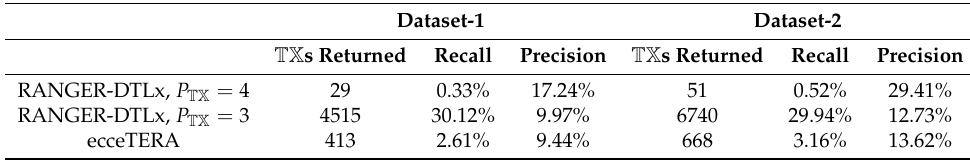
Table 3. Accuracy of TX event detection. The precision and recall for TX events inferred by each method are shown. A single optimal reconciliation is used per gene tree, and results are aggregated across all 500 gene tree/species tree pairs in each